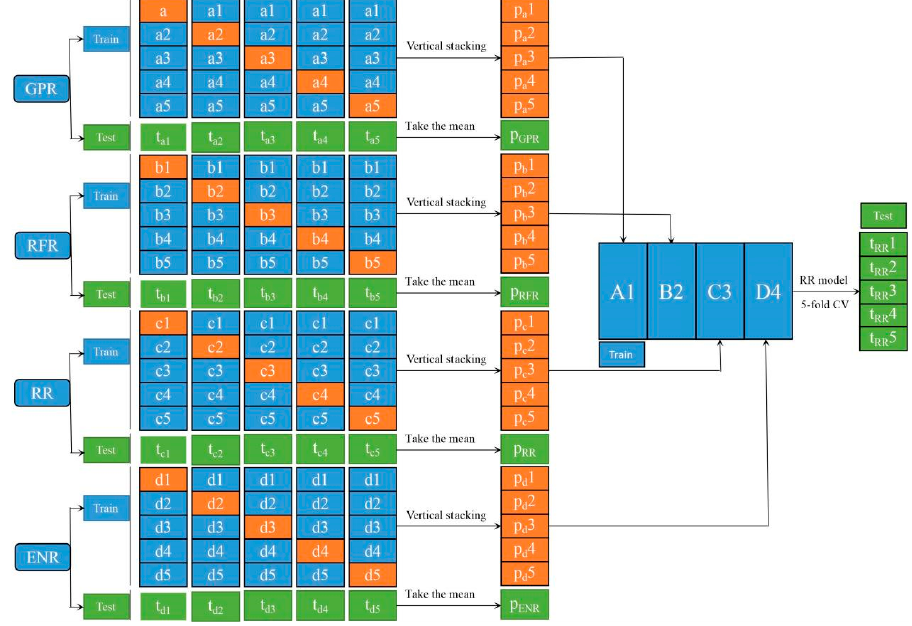
Figure 4. Ensemble learning model framework. GPR Gaussian process regression, RFR random forest regression, RR ridge regression, ENR elastic network regression, p predictions from different models.